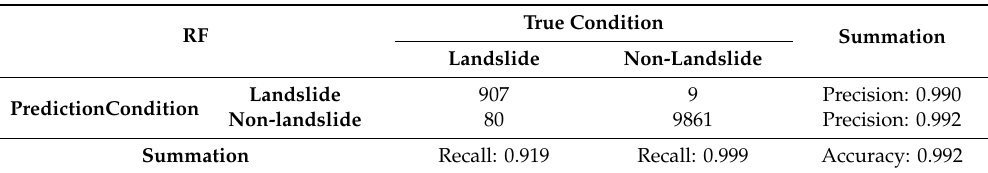
Table 8. Confusion matrix of RF.